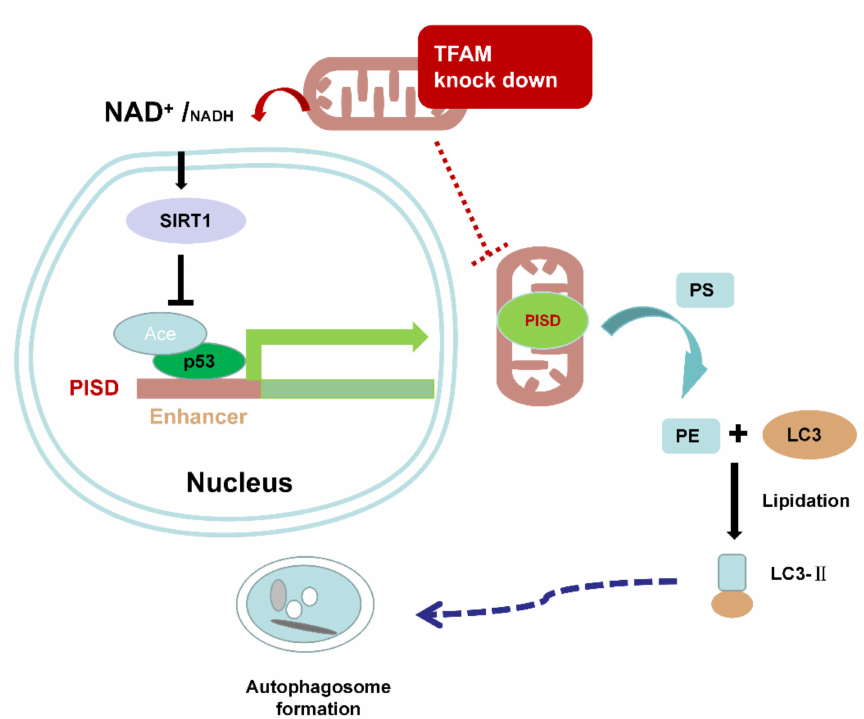
Figure 7. The schematic figure of this study. Downregulation of TFAM increased the NAD + / NADH ratio and upregulated SIRT1. SIRT1 deacetylated p53 and resulted in lowered transcription of PISD . The attenuated expression of PISD retarded